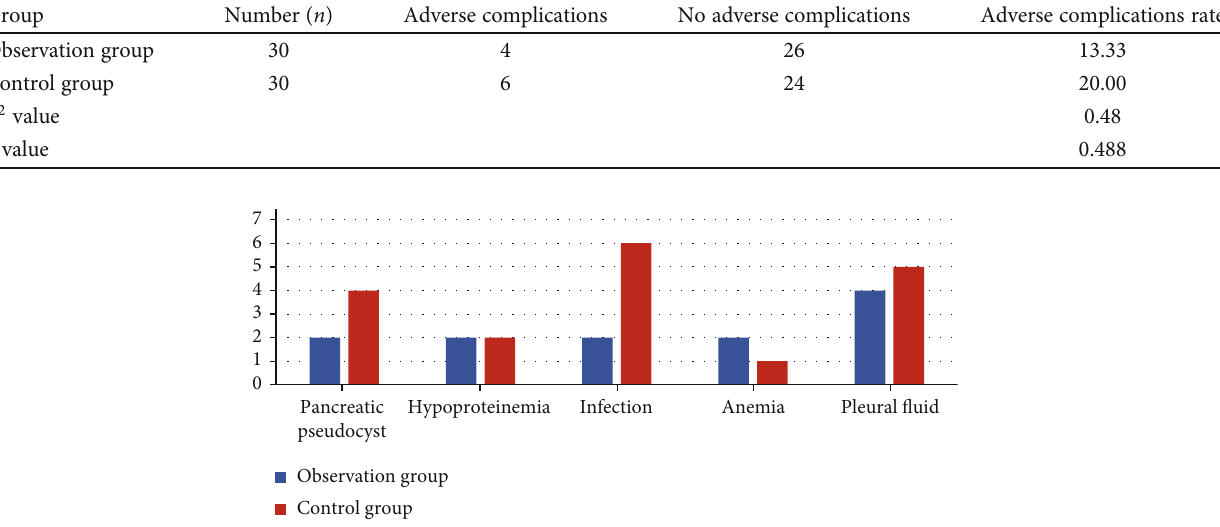
Figure 1: Treatment-related local or systemic complications.